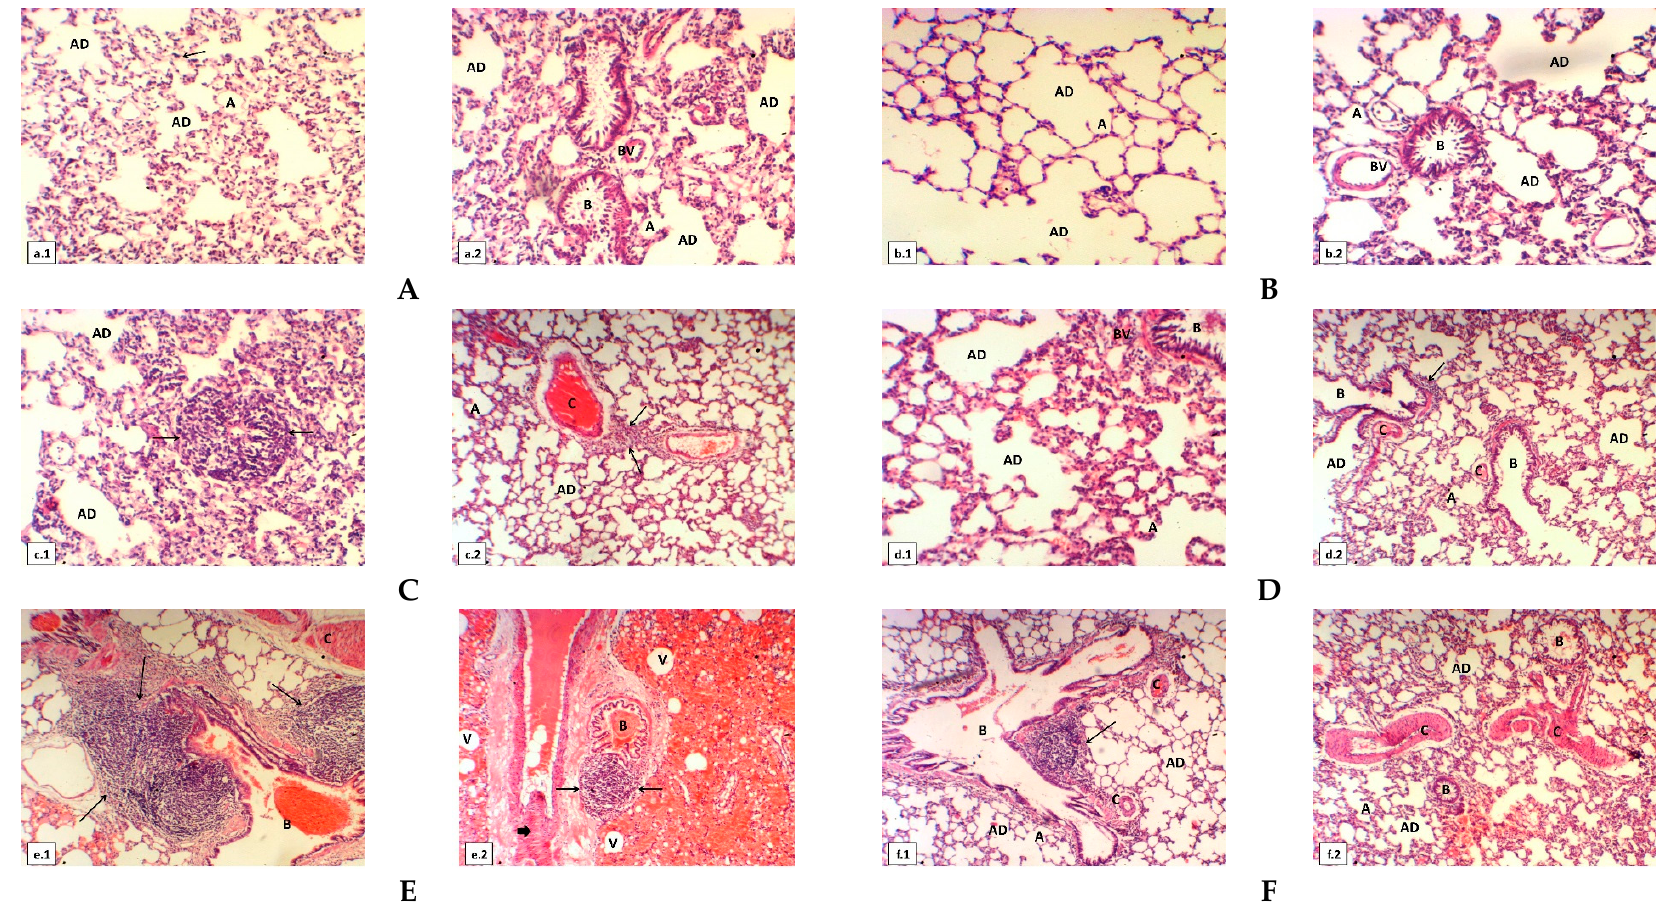
Figure 3. ( A ) Cross section of lung of normal healthy albino rats represents: ( a.1 ) normal architecture of lung tissue, alveolar ducts (AD), sacs, alveoli ( A ) and capillary (arrow); ( a.2 ) it shows normal bronchioles ( B ), alveolar ducts (AD), sacs and normal blood vessels (BV). ( B ) Cross section of lung of rats which fed on propolis extract: ( b.1 ) it shows alveolar ducts (AD) and alveoli (A); ( b.2 ) it illustrates normal bronchioles (B) with lumen is empty, alveolar ducts (AD), sacs and normal blood vessels (BV). ( C ) Cross section of another lung of low dose of aluminum silicate (5 mg/kg) induced rats: ( c.1 ) it shows numerous lymphocytes (arrows) and alveolar ducts (AD) are noticed; ( c.2 ) it shows congestion of blood vessels (C), numerous lymphocytes (arrows), alveolar ducts (AD) and alveoli (A). ( D ) Cross section of another lung of low dose of aluminum silicate (5 mg/kg) and propolis treated rats show clear signs repair of architecture of lung tissue: ( d.1 ) it represents the alveolar ducts (AD) and blood vessels (BV) with restoration of normal lung histological architecture; ( d.2 ) it shows alveoli (A) with more defined, mild